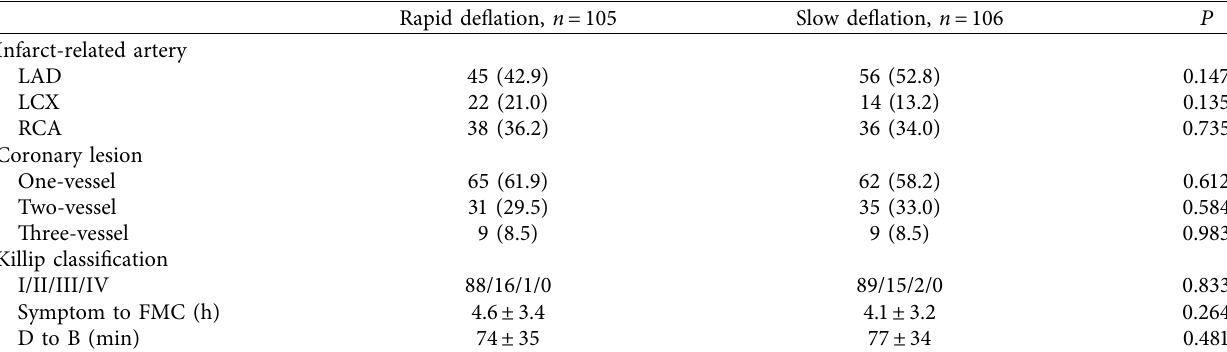
Table 2: Angiographic characteristics.